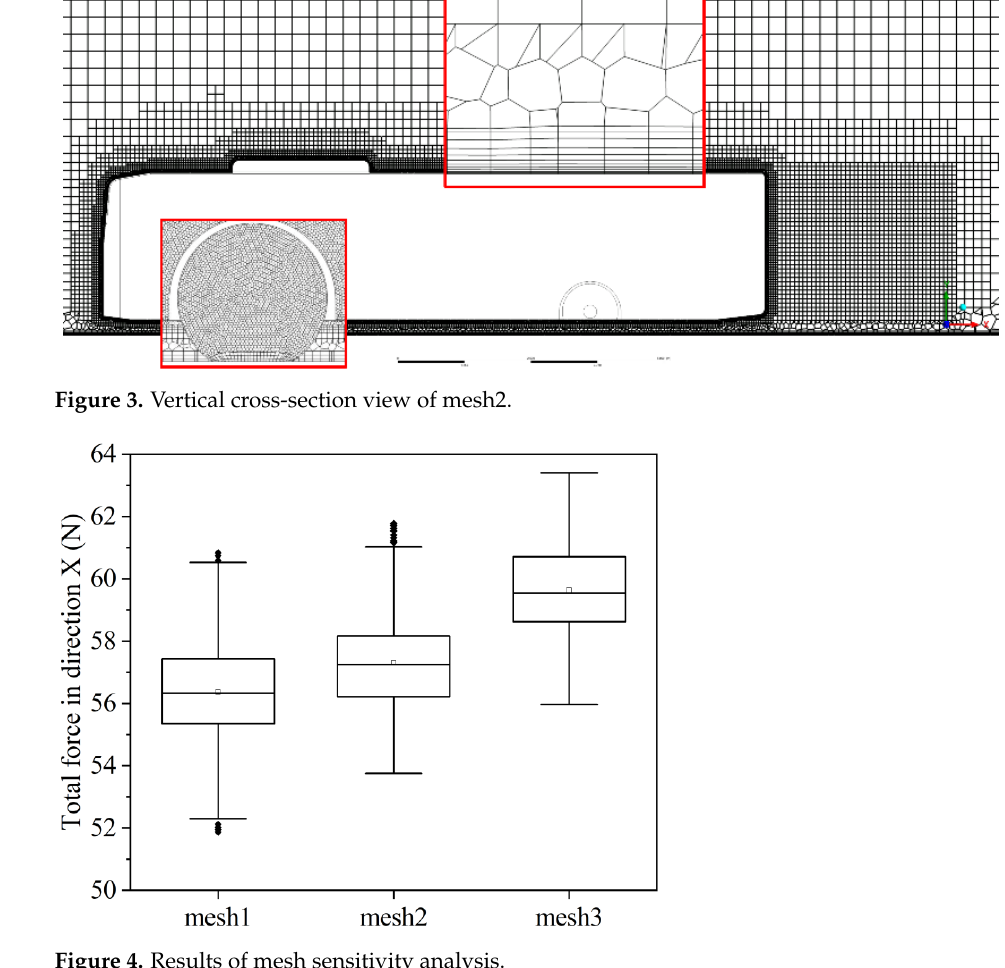
Figure 4. Results of mesh sensitivity